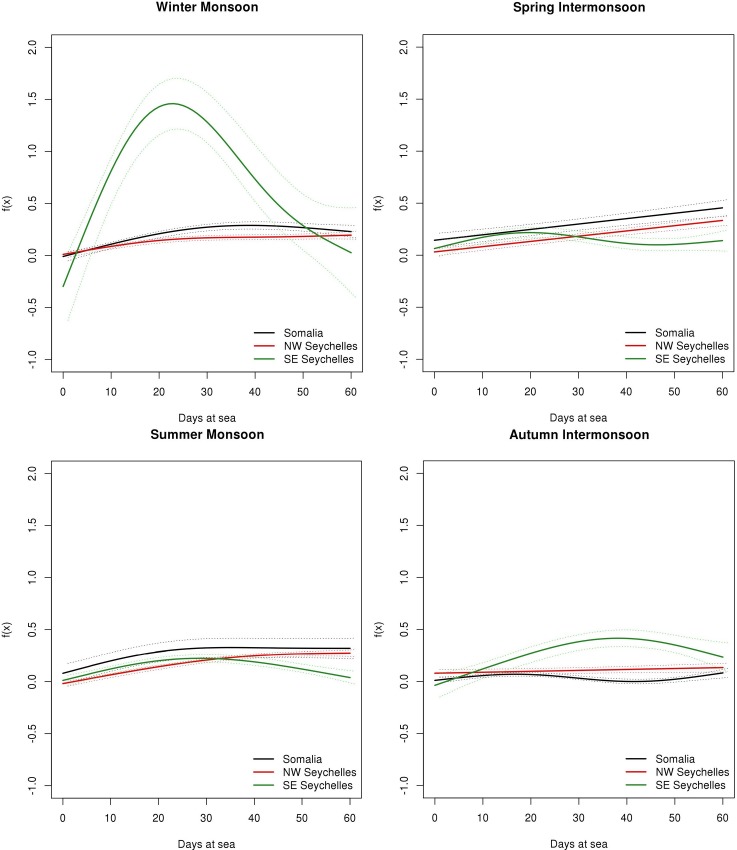
Functional shapes of the non-parametric relationship between non-tuna biomass and days at sea with 95% confidence intervals (dashed lines), for each period considered.